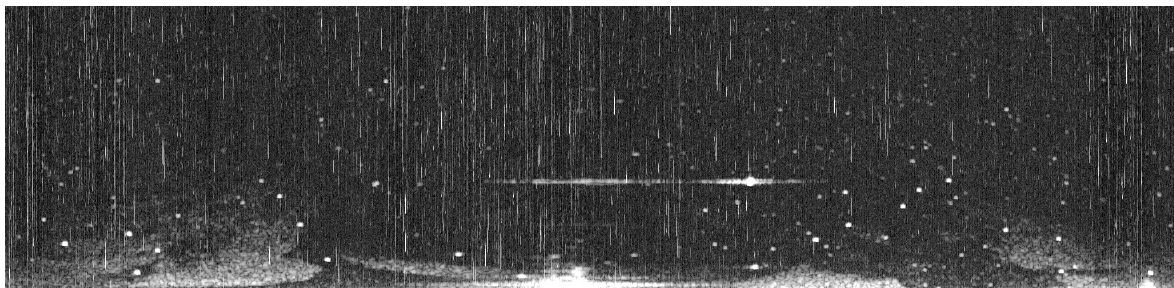
Figure 7. Original X band marine radar image sampled at 22:51:17 (red area of Figure 6) off the coast of Dalian.